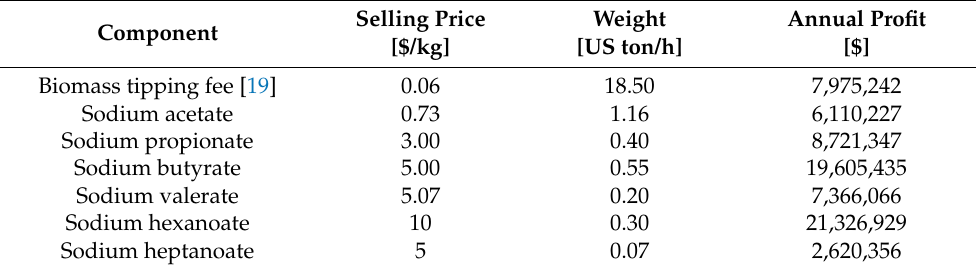
Table 6. Profit contributions of each revenue stream based on the market selling price and weight harvested [21].